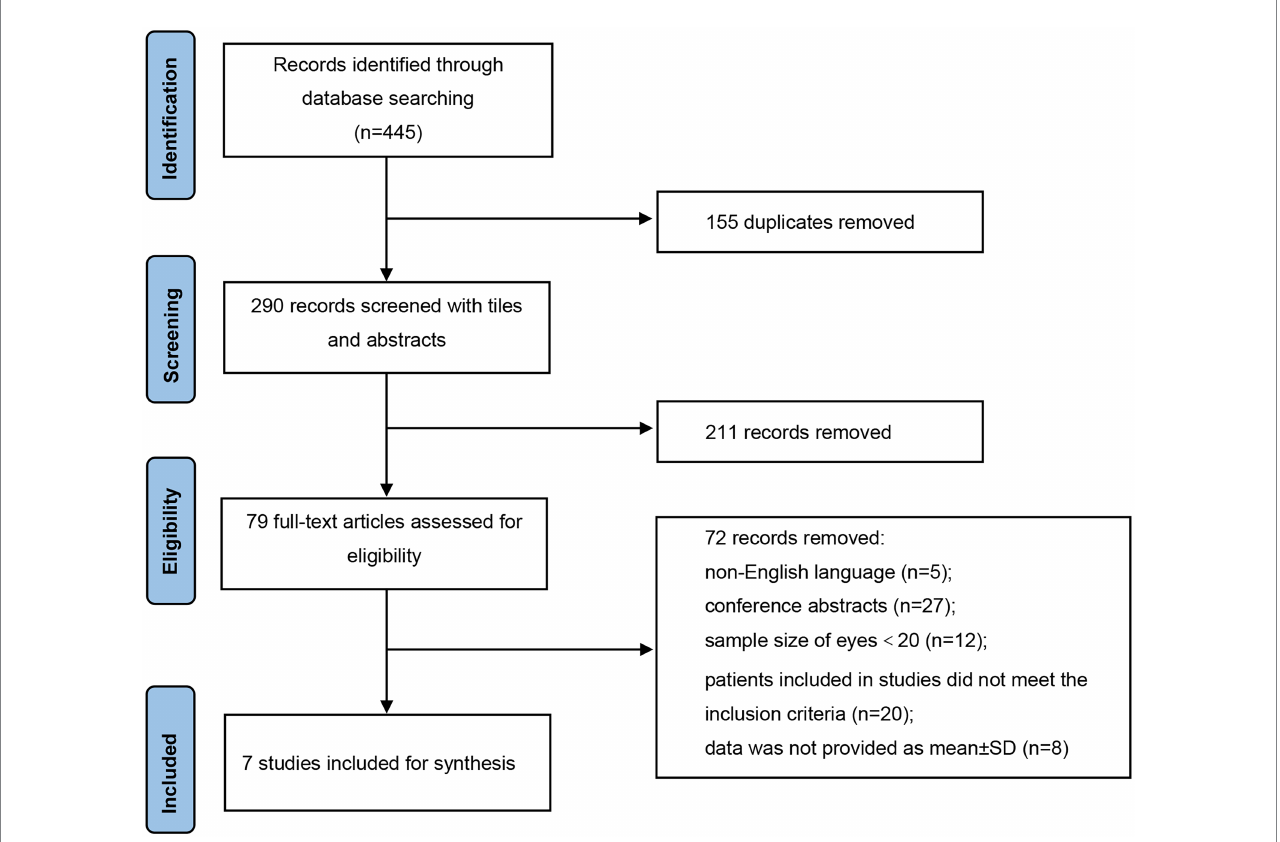
FIGURE 1 Flow diagram of the study selection